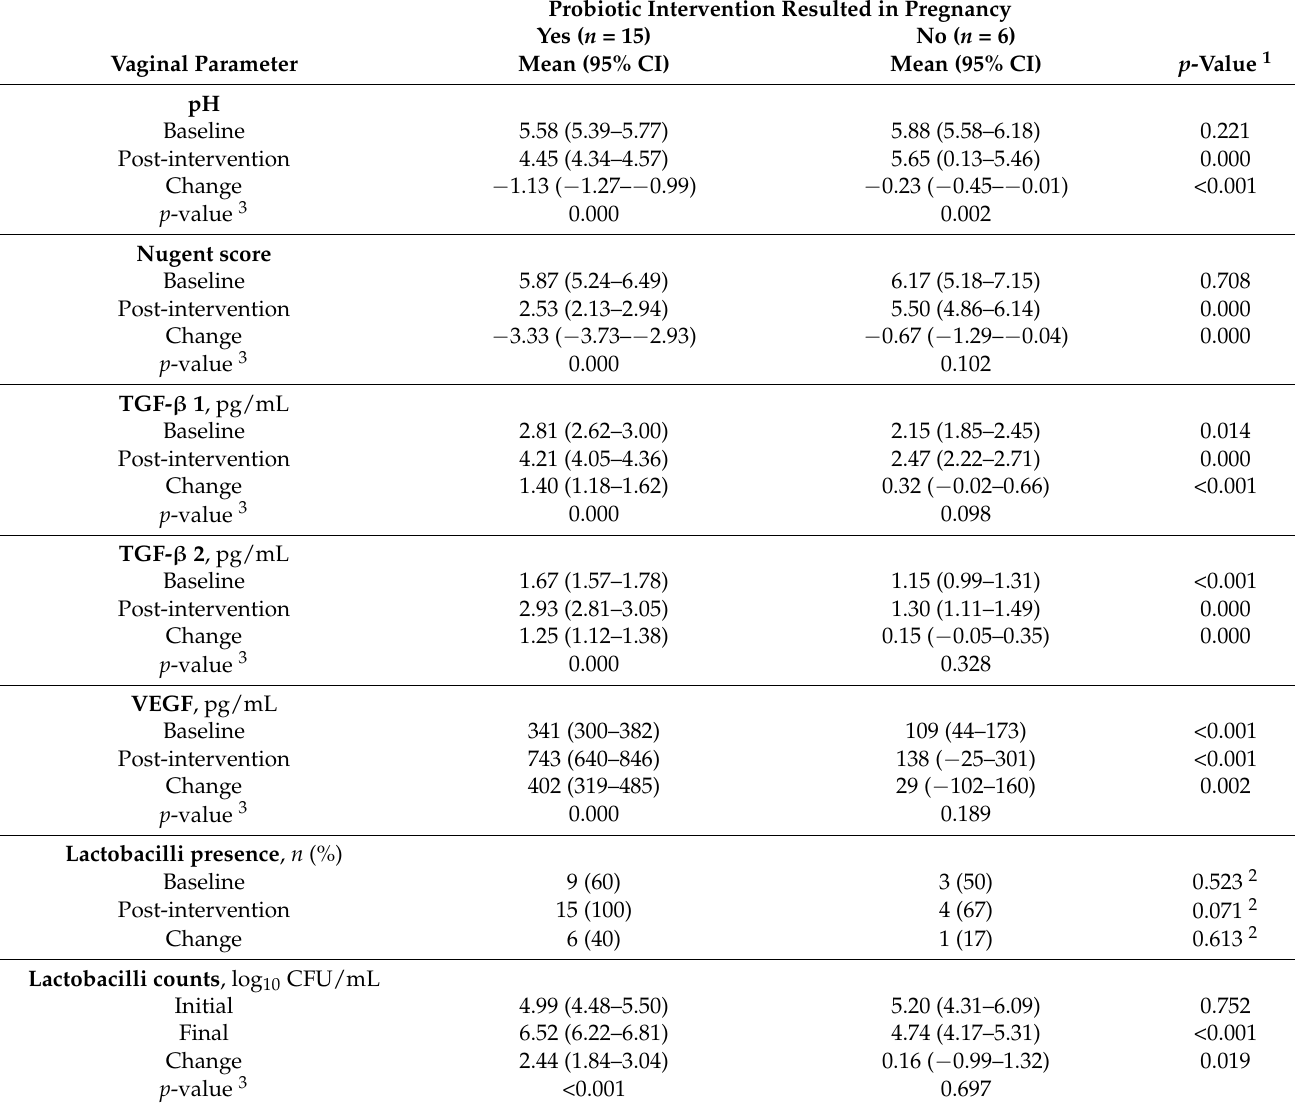
Table 5. Effect of the probiotic intervention with L. salivarius CECT5713 on the vaginal parameters of women who were able to complete a full-term pregnancy ( n = 15) and of those who did not ( n = 6) among the women that had a history of repetitive abortion (RA group; n =